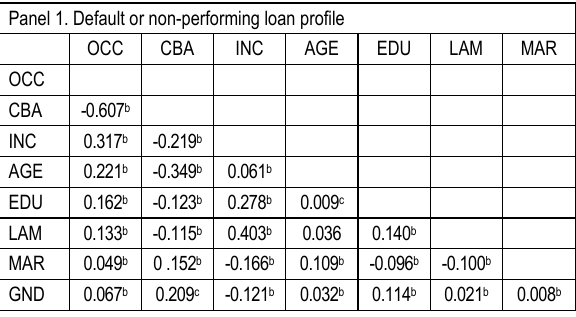
Table 4. Correlation results of credit risk